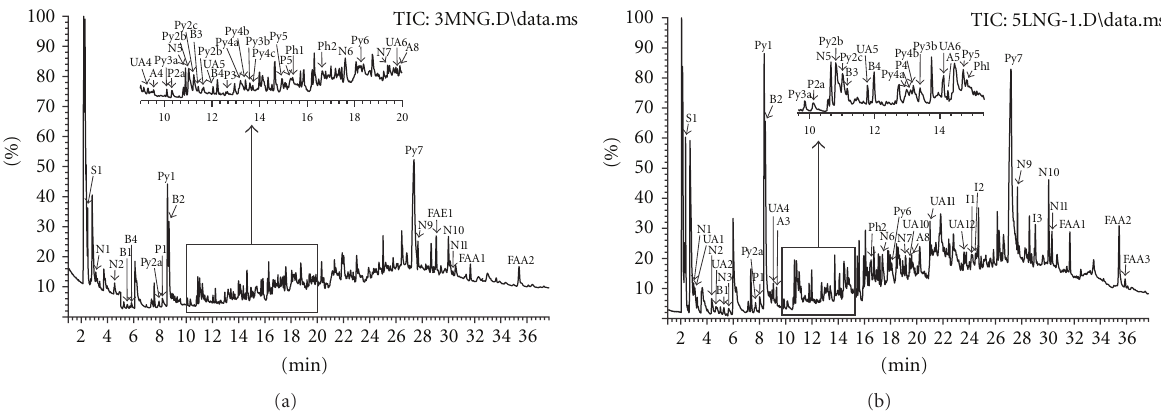
Figure 1: Chromatograms of thermolysis products of deep-frozen (a) and lyophilized (b) bone